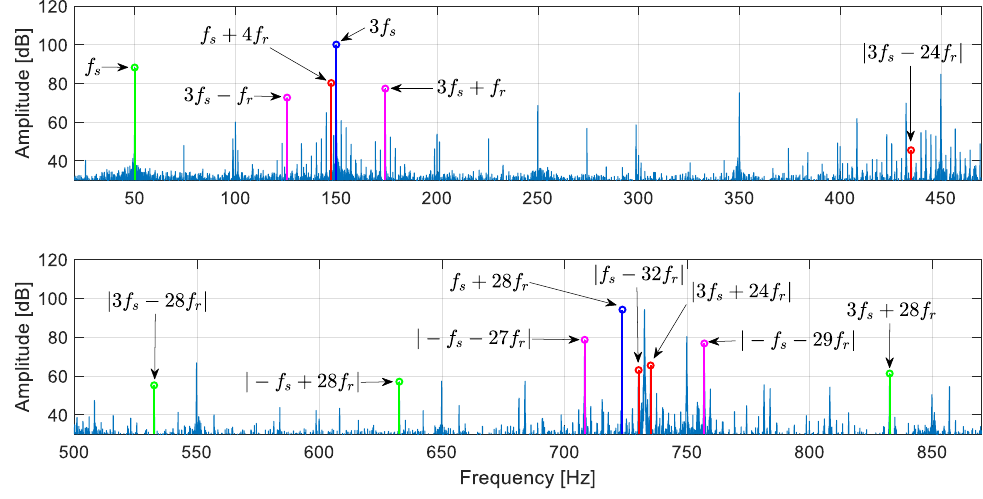
Figure 15. ZSV spectrum measured during laboratory tests for eccentricity case.